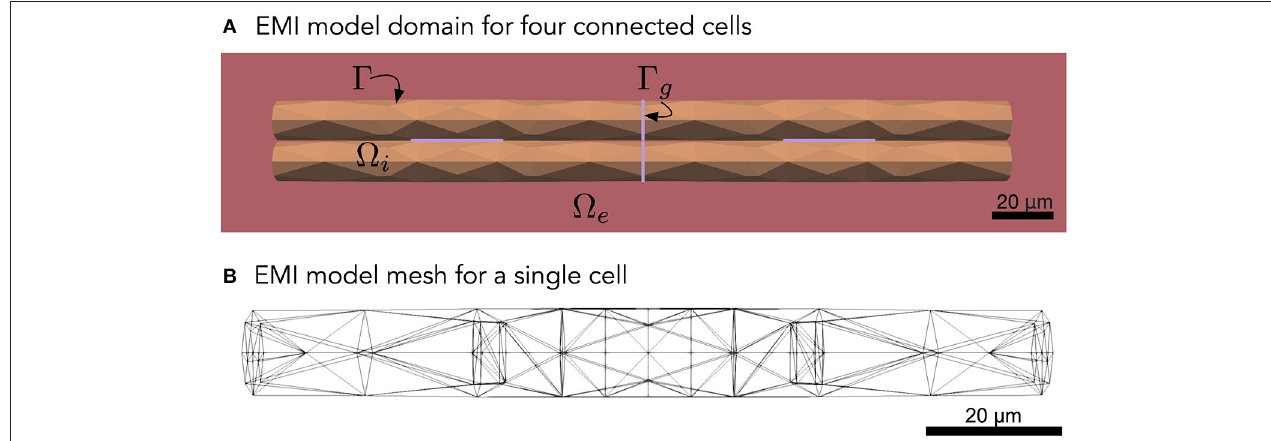
FIGURE 1 | (A) Illustration of an EMI model domain for four connected cells. The intracellular space (orange) is denoted by (cid:127) i and the extracellular space (red) is denoted by (cid:127) e . The cell membrane is defined as the interface between the intracellular and extracellular spaces and is denoted by Ŵ . Similarly, the intercalated discs (purple) are denoted by Ŵ g and are defined as the interface between neighboring cells. Each cell is shaped as a cylinder with a diameter increasing slightly toward the center of the cell. (B) Illustration of the finite element mesh used to represent a single cell in the EMI model simulations.